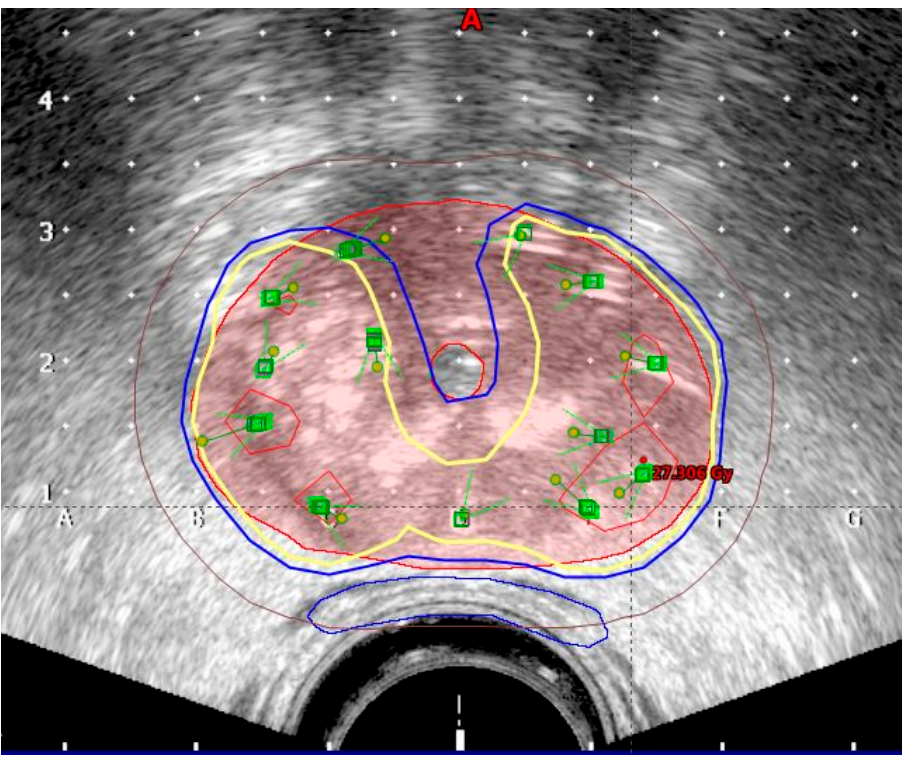
Figure 1. Isodoses in transrectal ultrasound image (red: 15 Gy; yellow: 9 Gy; blue: 8 Gy; brown: 5 Gy).